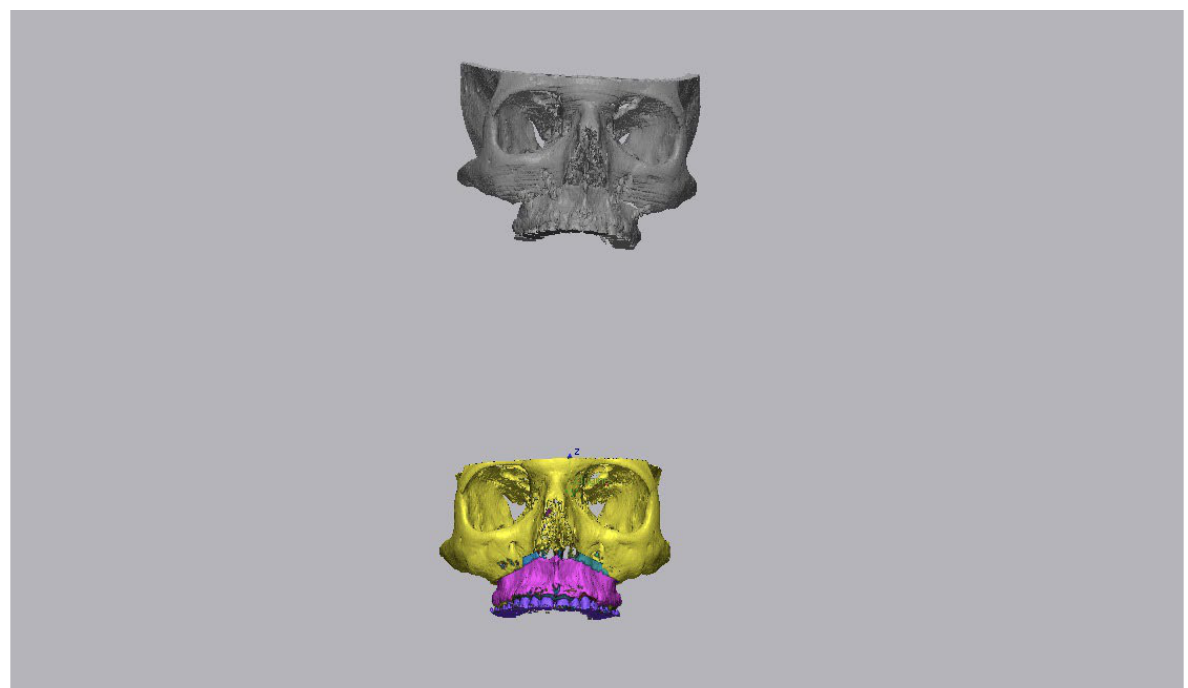
Figure 3. Import of the STL files, obtained, respectively, from the postoperative CBCT and the VSP, within the interface of Geomagic software.